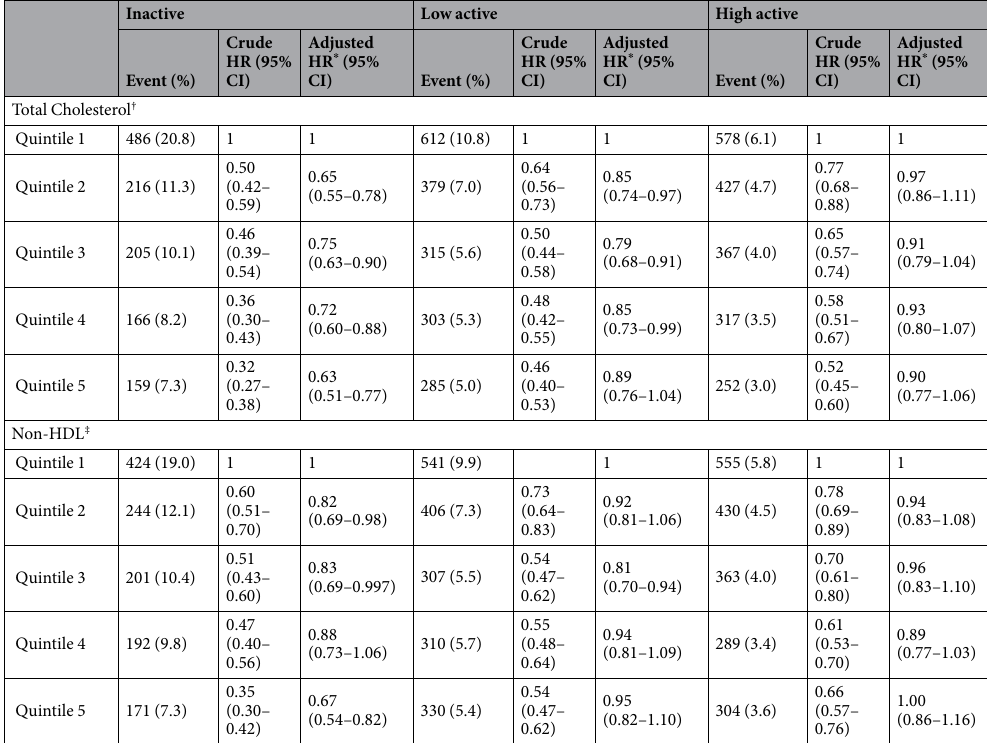
Table 4. Mortality Risks by Total Cholesterol Levels and Non-HDL Levels, and By Physical Activity Status Among Older Participants. * Adjusted for age, sex, body mass index, smoking, alcohol use, systolic blood pressure, diastolic blood pressure, hypertension, diabetes mellitus, coronary artery disease, cerebrovascular disease, white blood cell count, hemoglobin, albumin, geriatric nutritional risk index, uric acid, fasting glucose, estimated glomerular filtration rate, and urine protein level. † Interaction for total cholesterol and physical activity status, p value = 0.06. ‡ Interaction for non-HDL and physical activity status, p value = 0.01. Abbreviations: HR, Hazard ratio; CI, confidence interval.